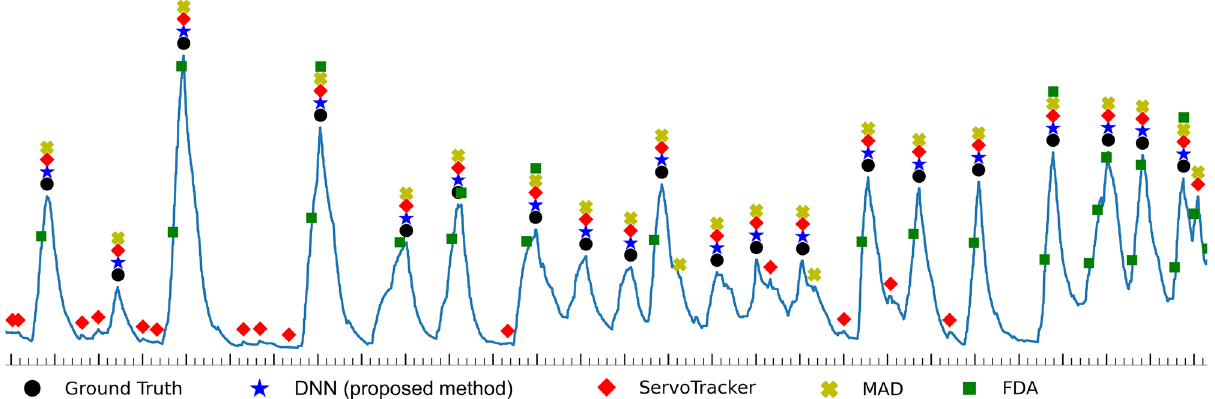
Figure 5. A representative Edi curve of peak detections by the ground truth, DNN (proposed method), ServoTracker, MAD, and FDA. The marker is a peak indication detected by each detector. The major and minor intervals on the x-axis are 1 and 0.2 s, respectively.